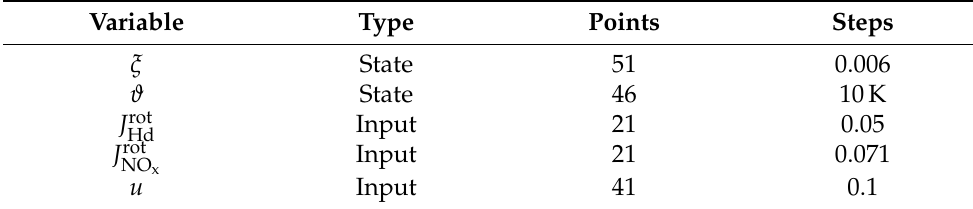
Table 1. State and input discretization for